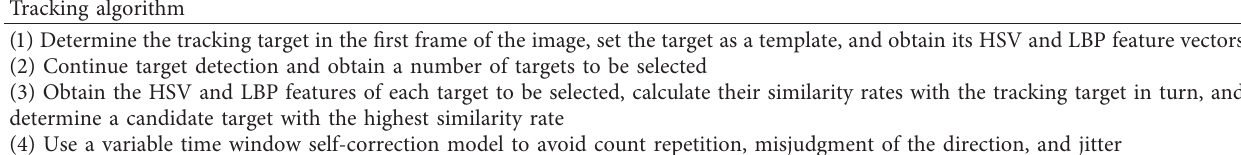
Figure 1: YOLOv3 detection algorithm flowchart. Table 1: The process of this tracking